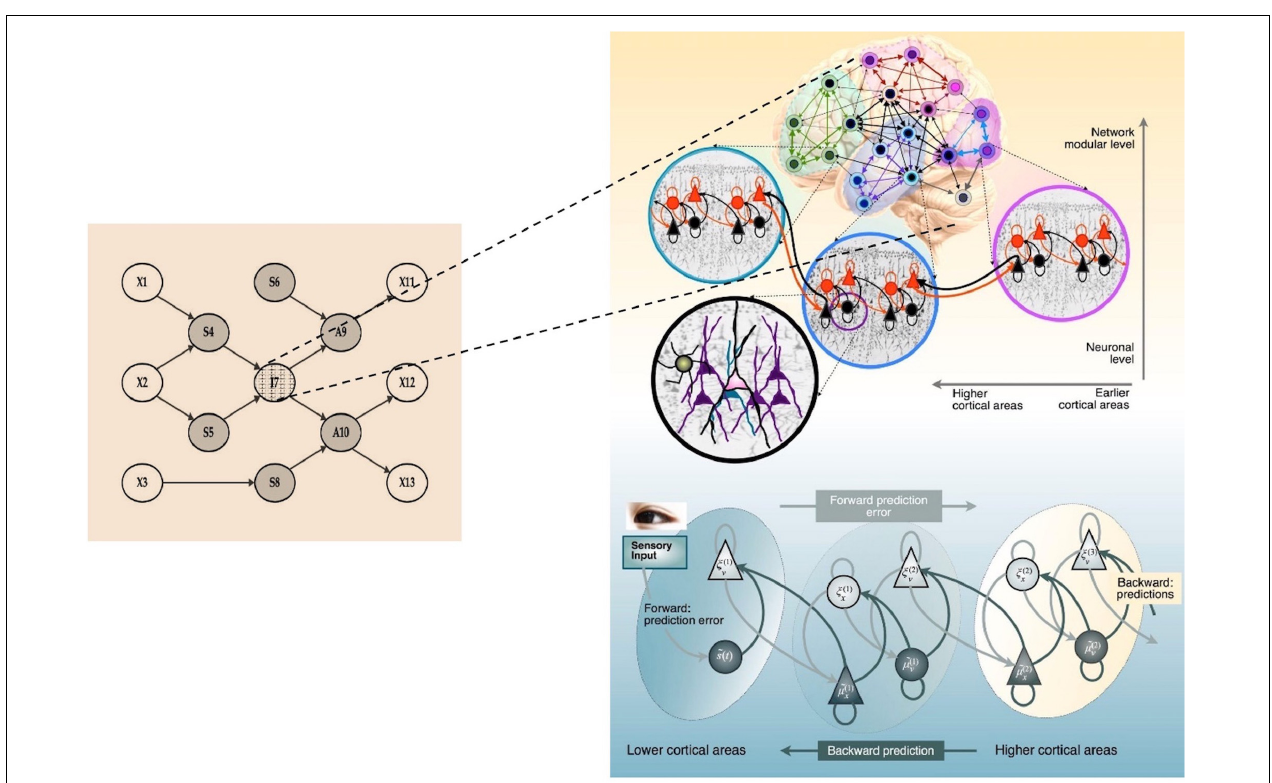
FIGURE 2 | A Markov blanket in the multiscale hierarchical organization of brain networks. The internal state, I7, of a Markov blanket has a hierarchical structure for minimizing prediction errors. In the right panel, red and bright triangles represent prediction errors from bottom-up sensory signals and black and dark triangles indicate top-down predictions (updated by prediction errors) under the implicit (deep or hierarchical) generative model. The process of hierarchical prediction, or deep active inference, may exist at various scales: between brain regions, between smaller nodes within a brain region, and even at the neuronal level. The Markov blanket is basically scale invariant; the nodes in the model could be cells, neurons, cortical columns, brain areas, organs in the body, individuals, organizations, or nations. The right panel image was adopted from Park and Friston